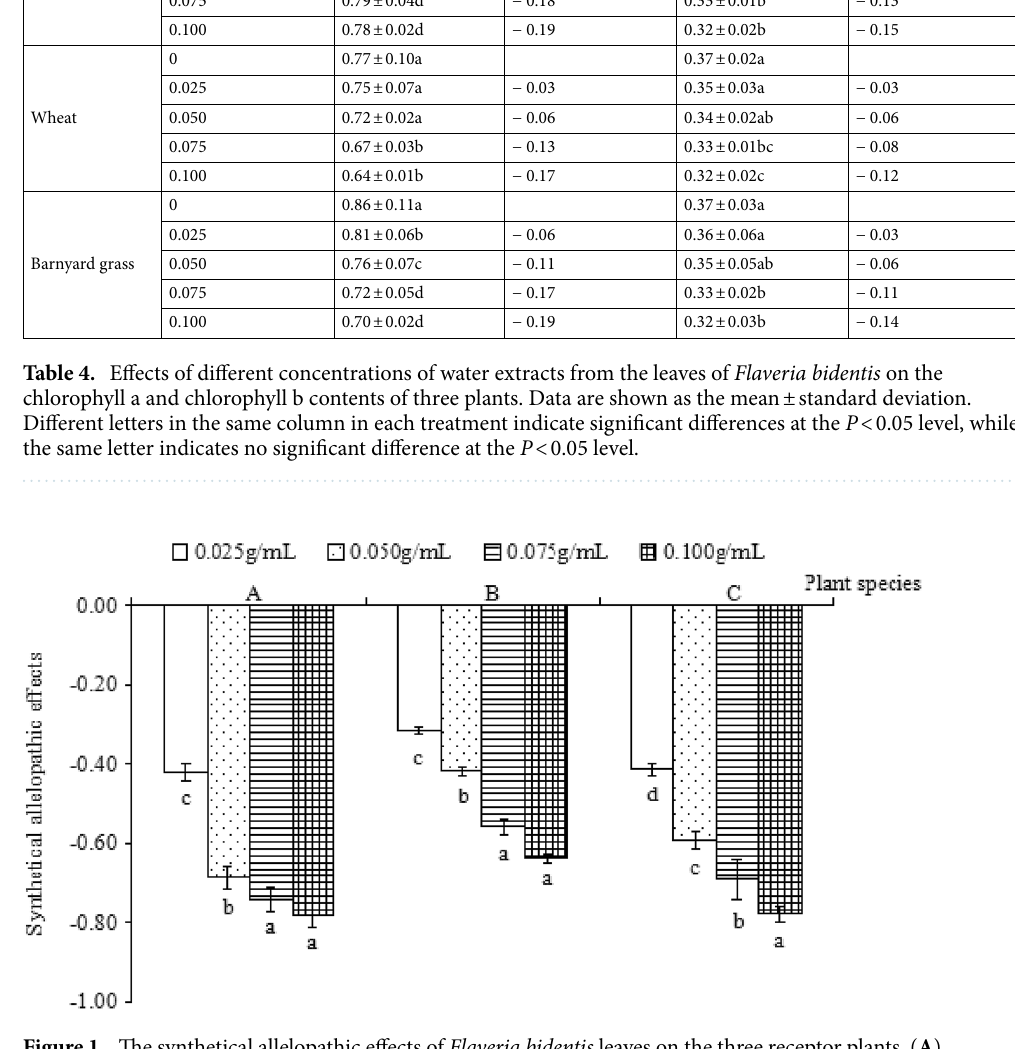
Figure 1. The synthetical allelopathic effects of Flaveria bidentis leaves on the three receptor plants. ( A ) Shanghai green, ( B ) Wheat, and ( C ) Barnyard